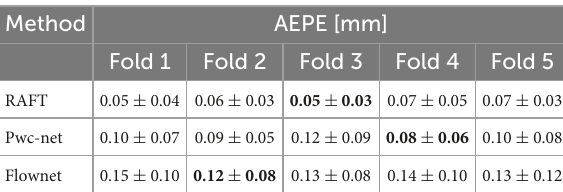
TABLE 2 Average end point error (AEPE) on simulated ultrasound